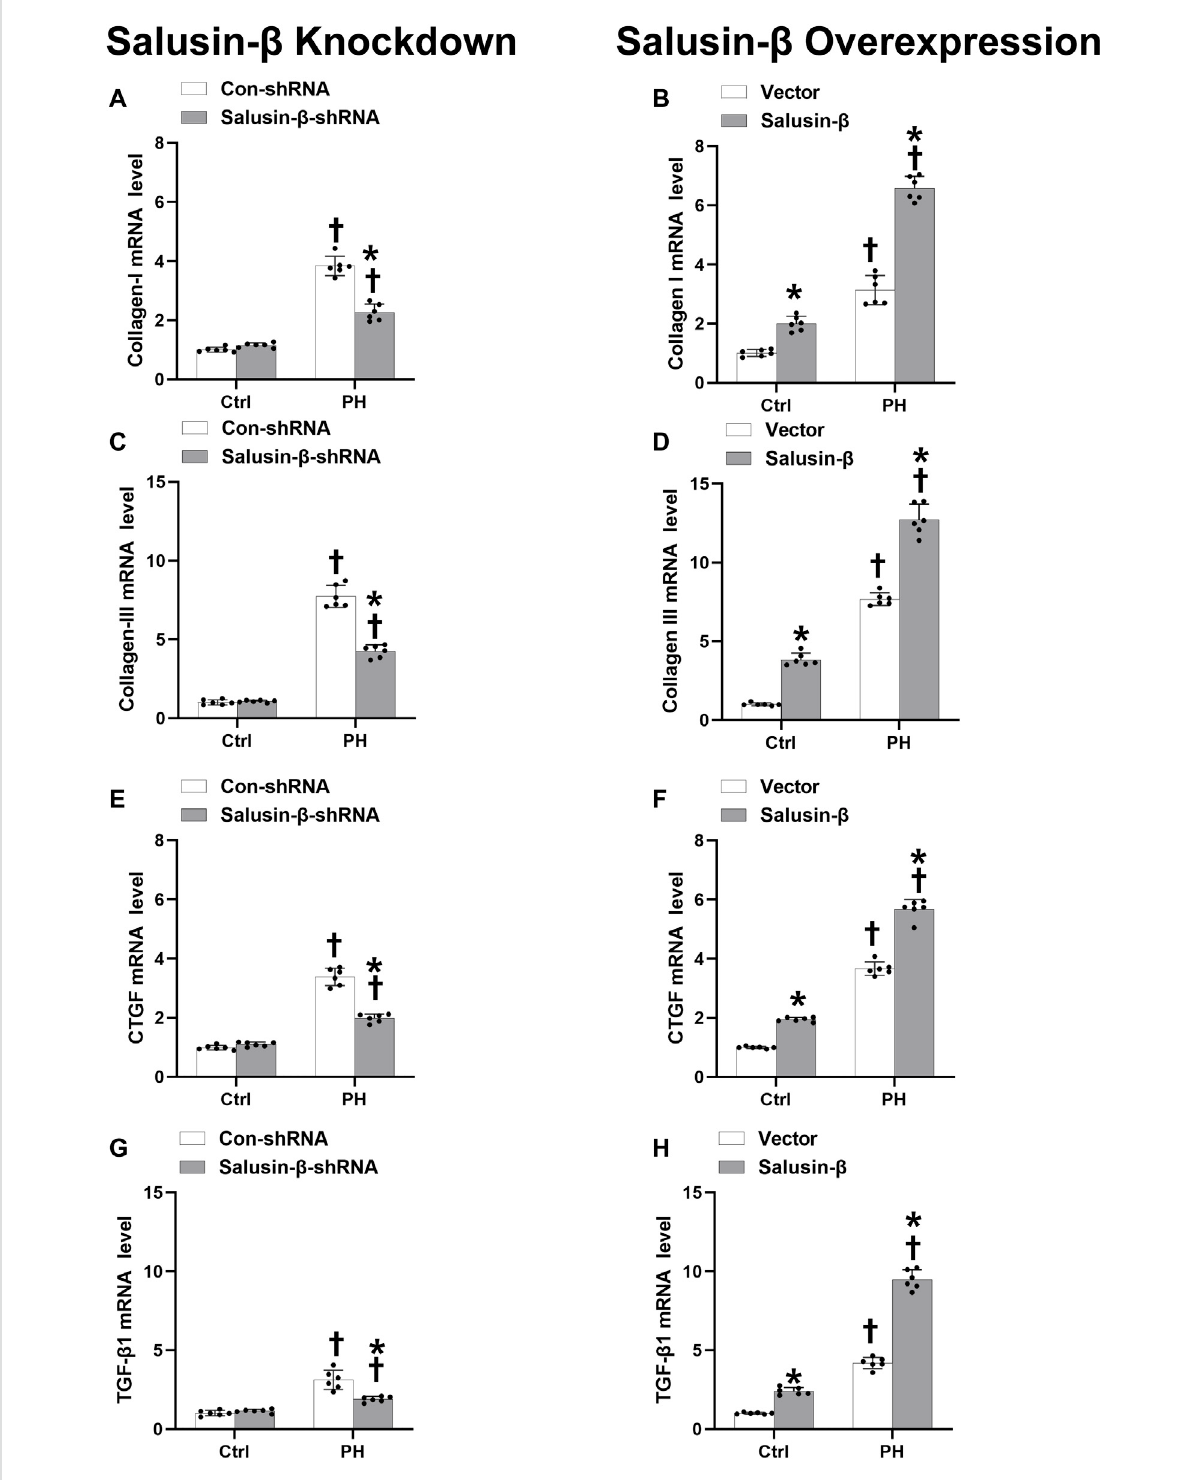
FIGURE 7 Effects of salusin- β knockdown on mRNA levels of fi brosis indexes of PASMCs: collagen I (A) , collagen III (C) , connective tissue growth factor (CTGF) (E) andtransforminggrowthfactor- β 1(TGF- β 1) (G) ;aswellastheeffectsofoverexpressionofsalusin- β oncollagenI (B) ,collagenIII (D) ,CTGF (F) andTGF- β 1 (H) ofPASMCsisolatedfromcontrolandMCT-inducedPHrats.Valuesaremean±SE.* p < 0.05comparedwithCon-shRNAorvector. † p < 0.05 compared with control (Ctrl) rats. n = 6 for each